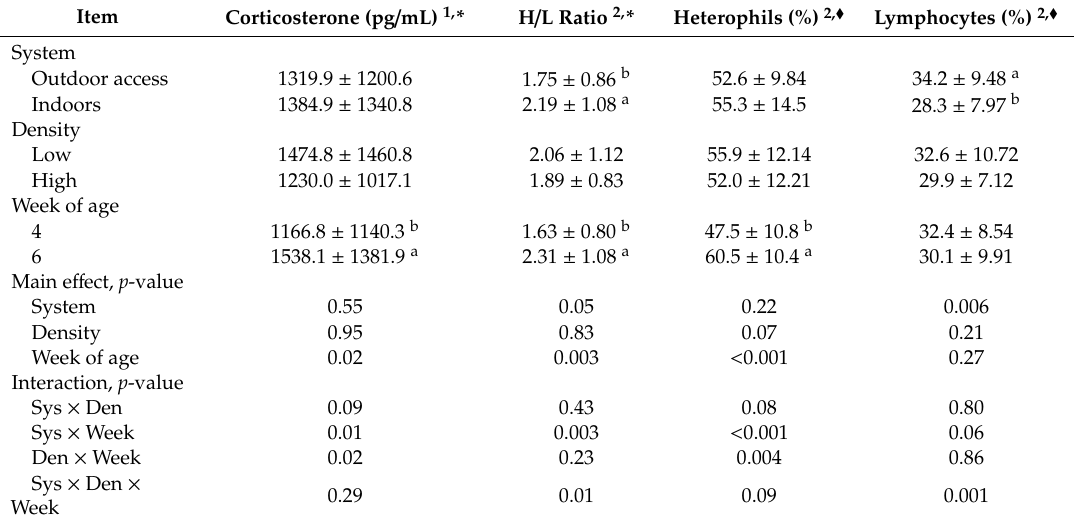
Table5. Table 5. LS Means of the effects of system, density and week on stress indicators of commercial-line broilers .